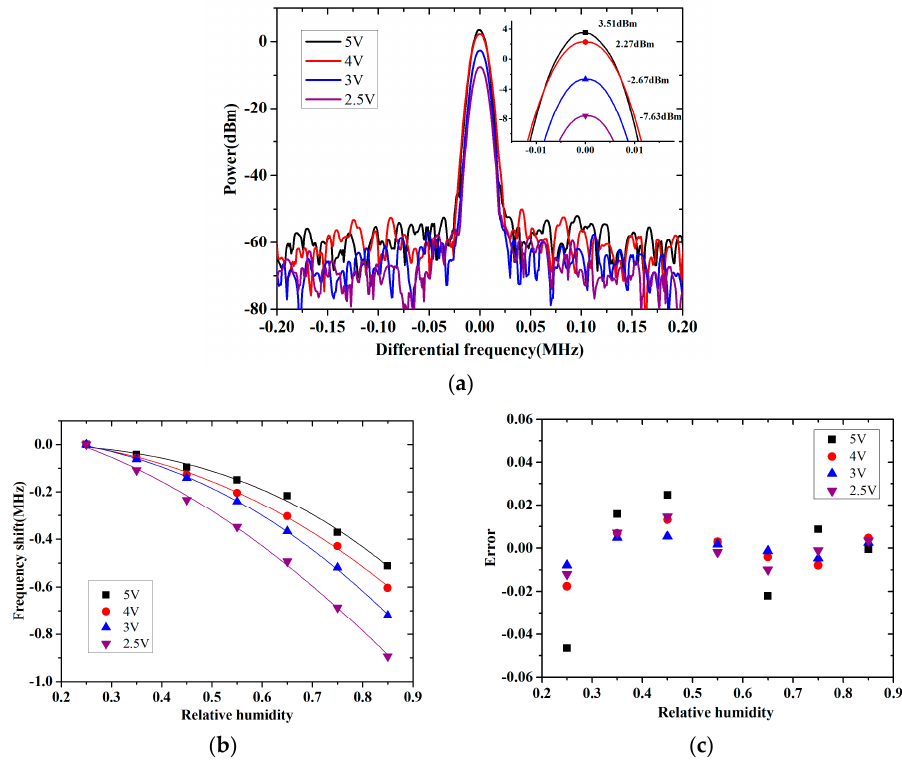
Figure 10. Effect of the supplied voltage on output frequency signal of the sensor sample: ( a ) power of the signal; ( b ) the frequency shift with relative humidity; ( c ) measurement error.